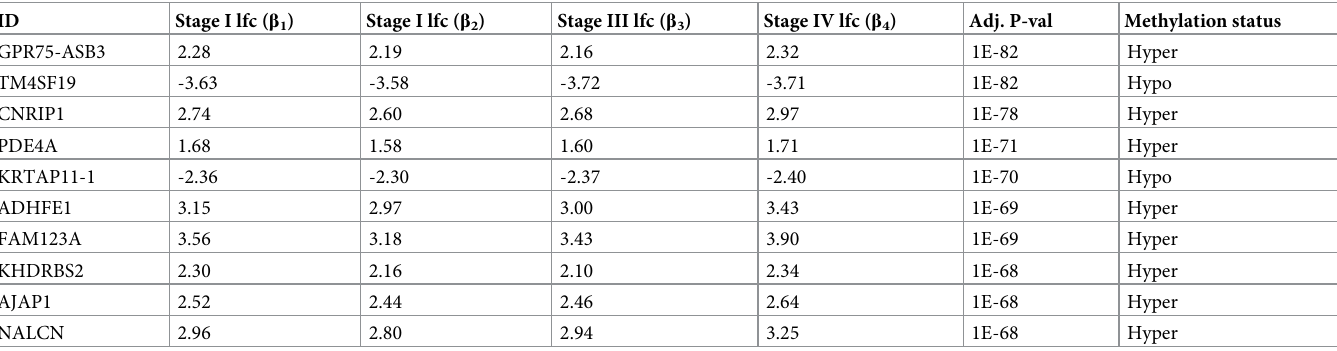
Table 2. Top ten genes of the linear model at the probe level.